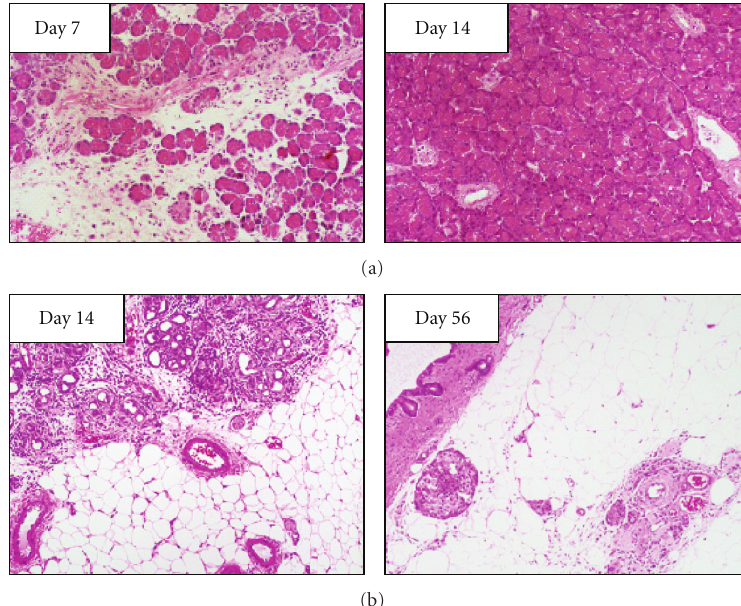
Figure 2: Representative photomicrographs of the pancreas after intraductal infusion of 40 μ L/100 g body weight of 3% NaTc solution (a) or after intraductal infusion of 50 μ L oleic acid (b). (a-left) On day 7 after intraductal infusion of NaTc, acinar architecture was partially destroyed, and infiltration of inflammatory cells was observed. (a-right) On day 14 after intraductal infusion of NaTc, the pancreas recovered with normal histological features (Hematoxylin and eosin staining, original magnification × 25). (b-left) On day 14 after intraductal infusion of oleic acid, acinar architecture was partially destroyed and replaced by fatty tissue. Tubular complexes were surrounded by fatty tissue. (b- right) On day 56 after intraductal infusion of oleic acid, almost all pancreatic parenchymal tissues were replaced by fatty tissue, and only islet cells were observed (Hematoxylin and eosin staining, original magnification ×